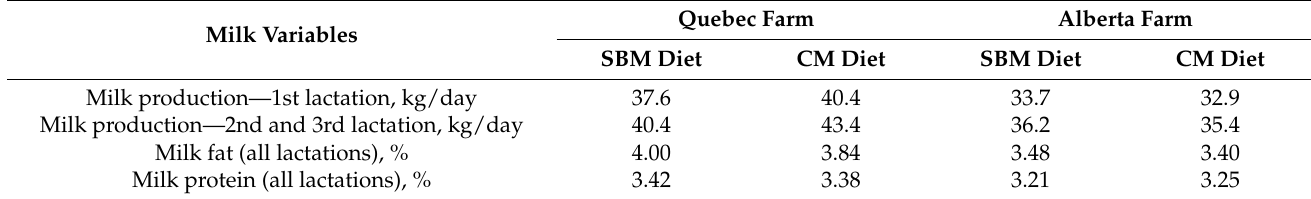
Table 2. Average daily milk production and composition for the simulated dairy farms. Milk